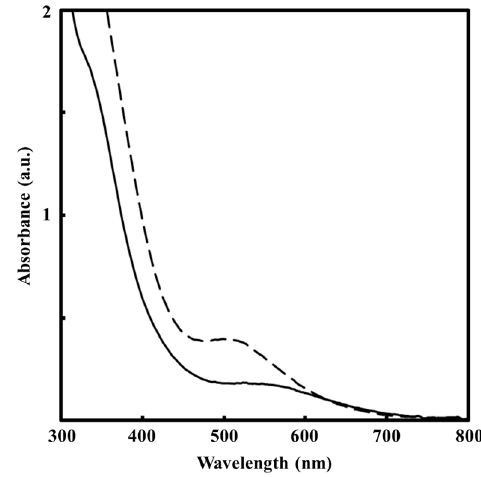
Figure 1. Absorption spectra of S aq (dashed line) and S EtOH (solid line).